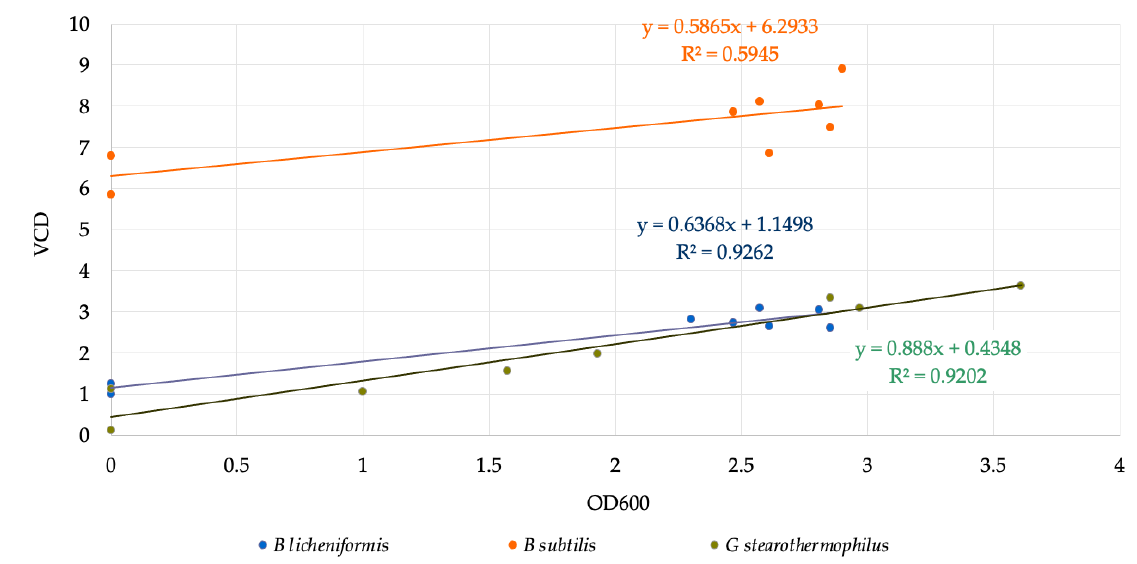
Figure 2. Correlation curve for VCD and OD600.